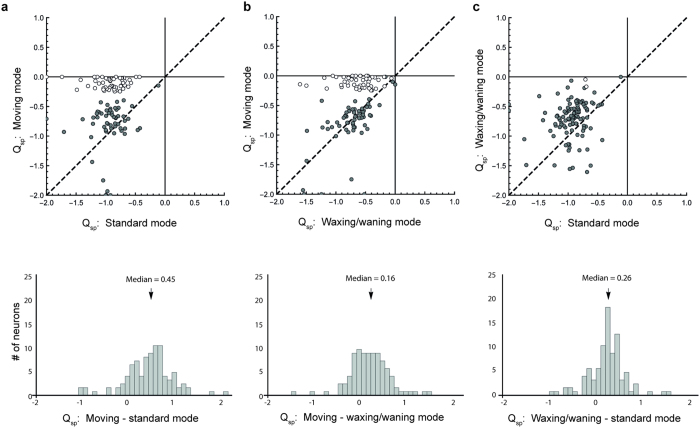
Changes in Qsp between two modes.The upper row compares the values of Qsp in tests conducted in (a) the standard and the moving modes, (b) the waxing/waning and the moving modes, and (c) the standard and the waxing/waning modes. White circles represent neurons that were changed from being non-speed-tuned (in the mode specified on the x-axis) to being speed-tuned (in the mode specified on the y-axis). Black circles represent all other neurons. The dashed lines represent values where Qsp was identical in the two modes. The lower row illustrates the distributions of the difference of Qsp in different modes.